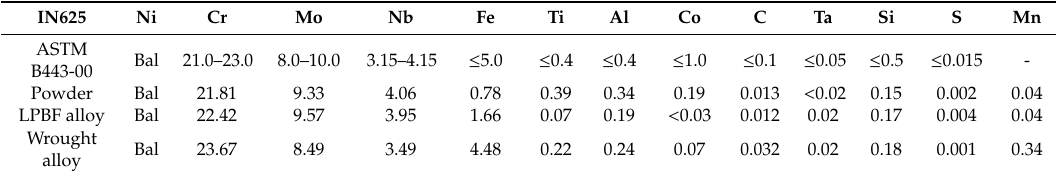
Figure 1. ( a ) Rectangular blanks and cubic specimens on the build plate; ( b ) tensile specimens (dimensions in mm; * - reference dimension) [24]. Table 1. Chemical composition of IN625 alloy (in wt.